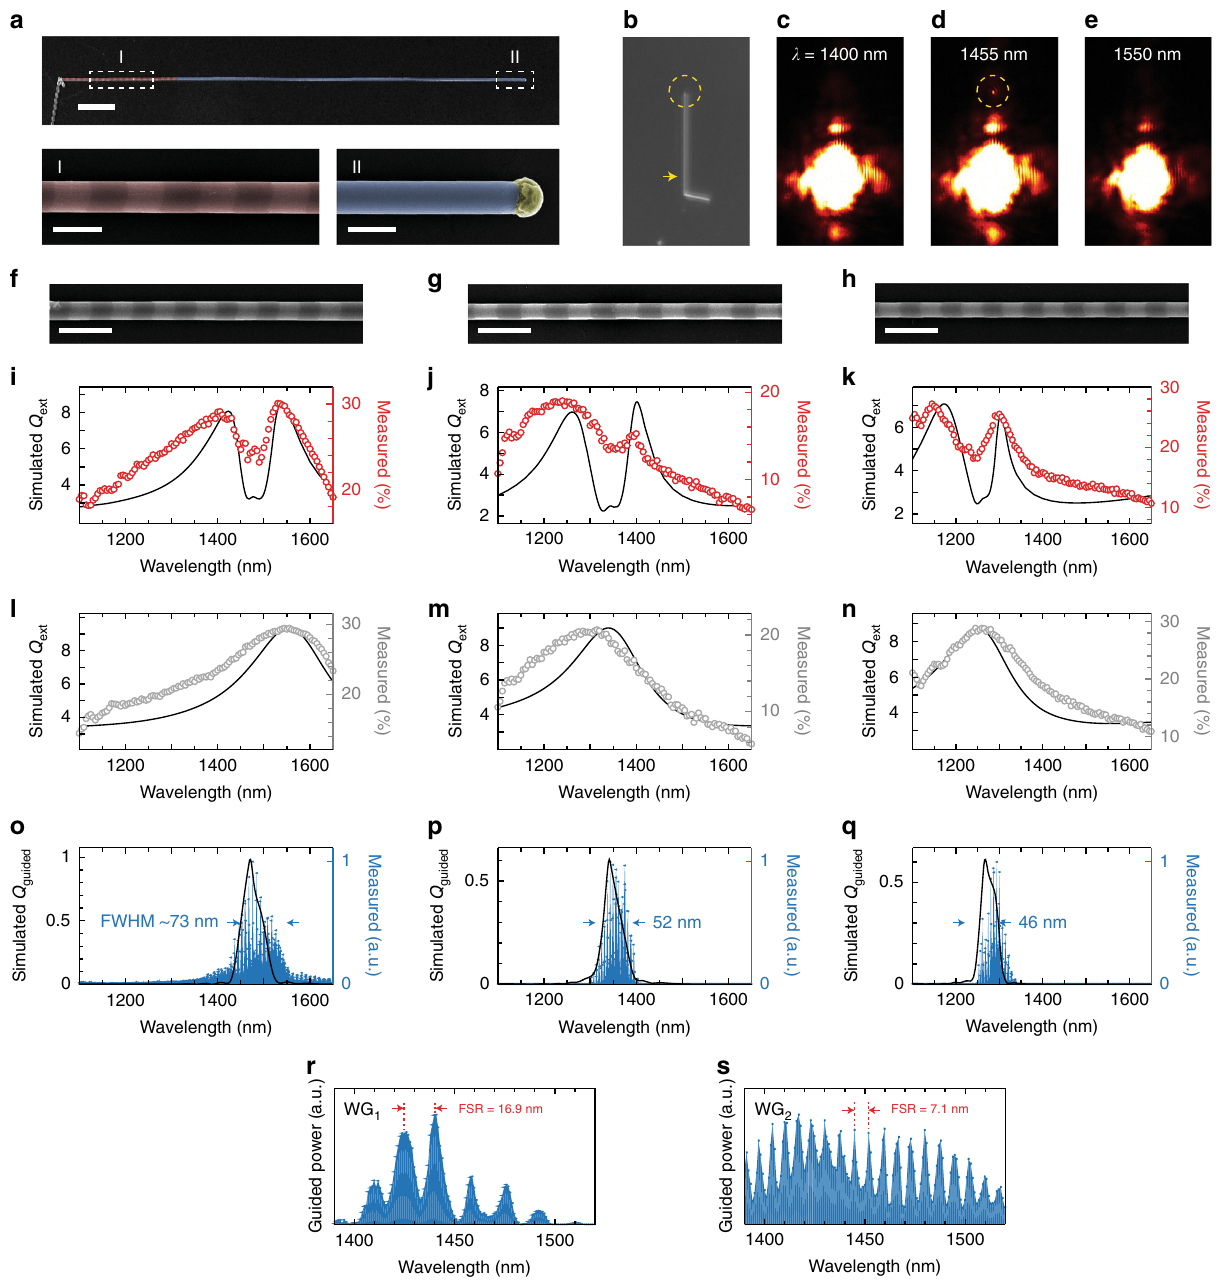
Fig. 4 Experimental validation of tunable, narrow-band guiding by NW GSLs. a (Top) False-colored SEM image of a NW GSL (red) with d = 334 ± 1 nm and p = 781 ± 9 nm prepared by the doping-inverted ENGRAVE process followed by a 50 μ m-long NW WG (blue); scale bar: 5 μ m. (Bottom) Magni fi ed views of dotted regions in the top image; scale bars: 500 nm. b – e False-colored optical images of the NW from a without an excitation beam ( b ) and under excitation at wavelengths of 1400 nm ( c ), 1455 nm ( d ), and 1550 nm ( e ). Yellow arrow and circles denote locations of the excitation beam and the NW tip, respectively. f – h SEM images of GSLs with geometrical parameters of d = 334 ± 1 nm, p = 781 ± 9 nm ( f ), d = 284 ± 3 nm, p = 882 ± 6 nm ( g ), d = 266± 1 nm, p = 772 ± 6 nm ( h ); scale bars, 1 μ m. i – q Spectra of GSL extinction ( i – k ), NW WG extinction ( l – n ), and WG emission ( o – q ). Experimental measurements (right-hand axes) are shown as circles (and blue shaded area for guided spectra), and simulated spectra (left-hand axes) are shown as black lines. r – s Fabry-Perot patterns in guided power spectra for NW WGs with length of 21 μ m ( r , WG 1 ) and 53 μ m ( s , WG 2